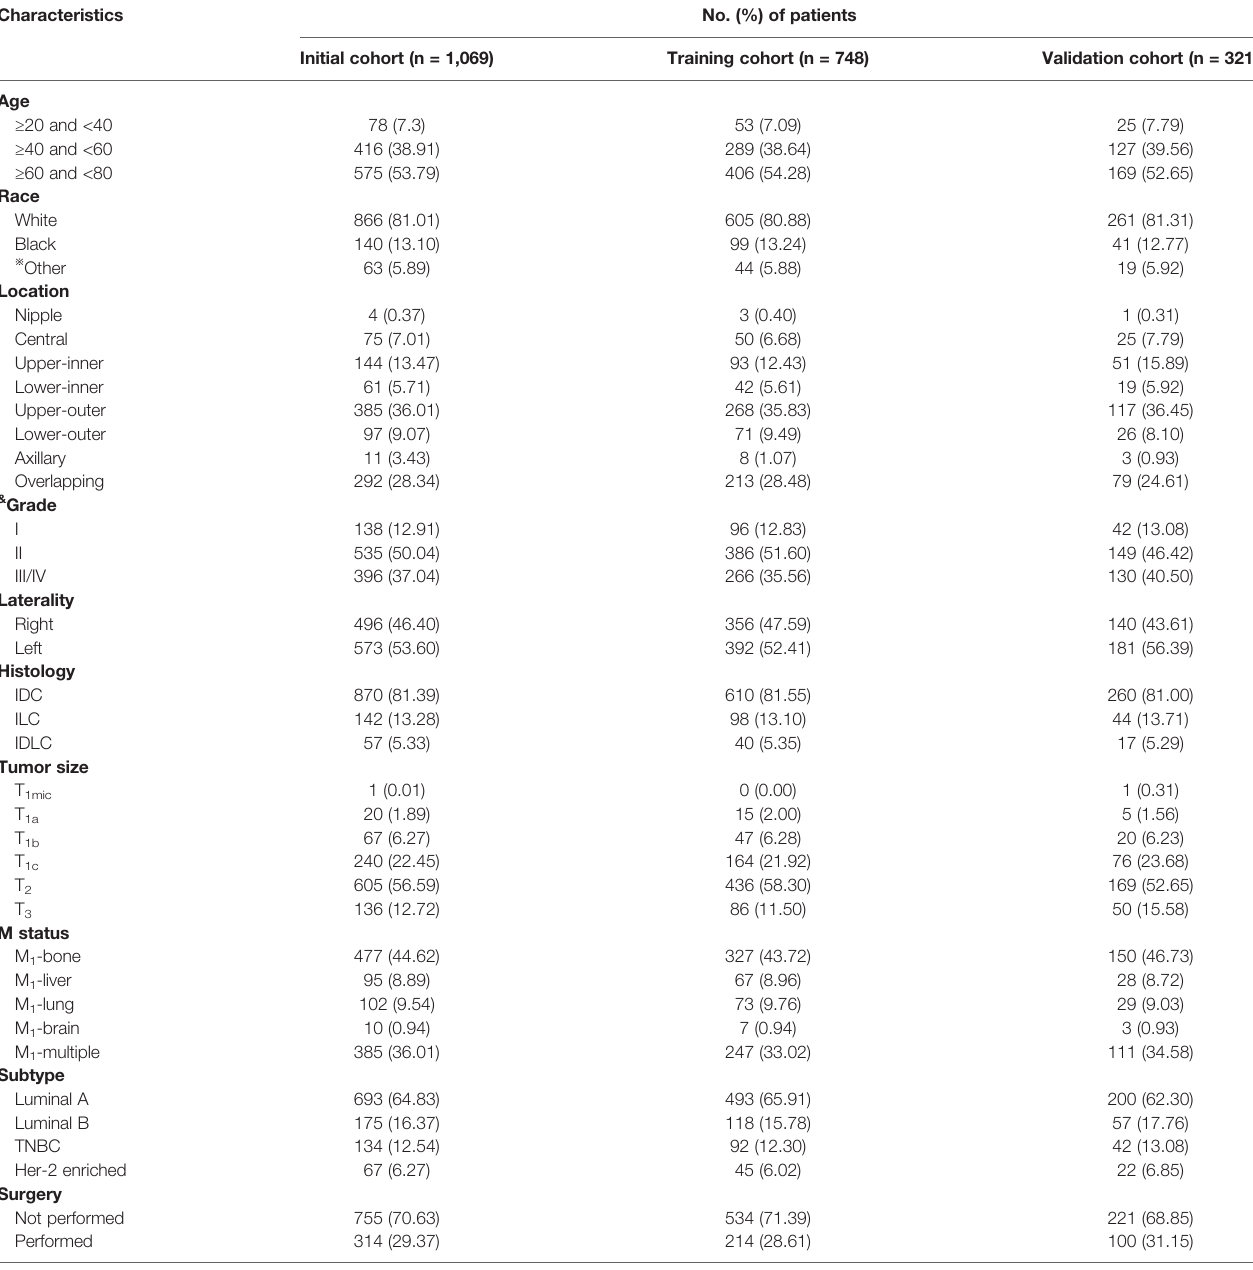
TABLE 1 | Clinicopathological characteristics of female patients with negative lymph node status but distant metastasis in training and validation cohorts.